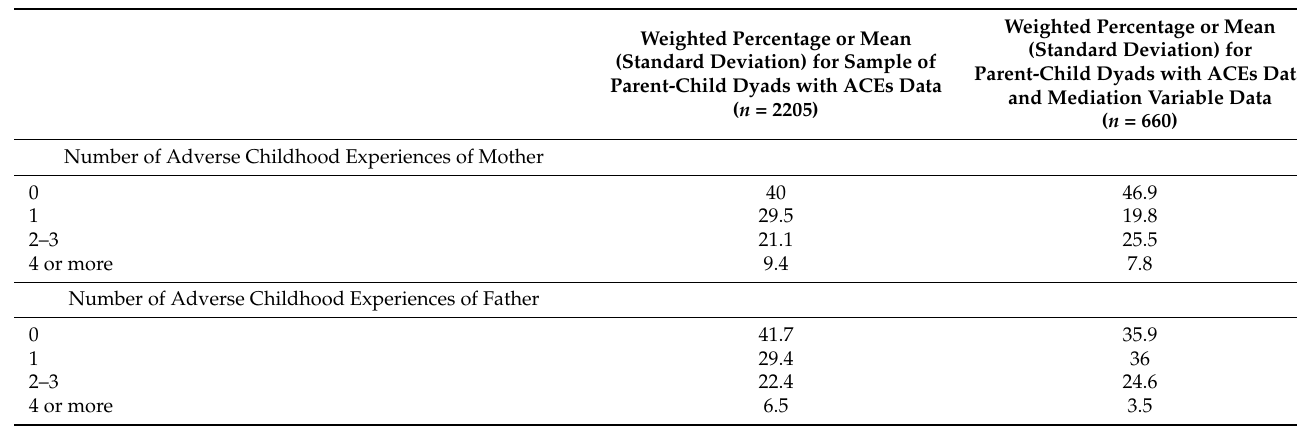
Table 2. Cont. Weighted Percentage or Mean (Standard Deviation) for Sample of Parent-Child Dyads with ACEs Data ( n = 2205)